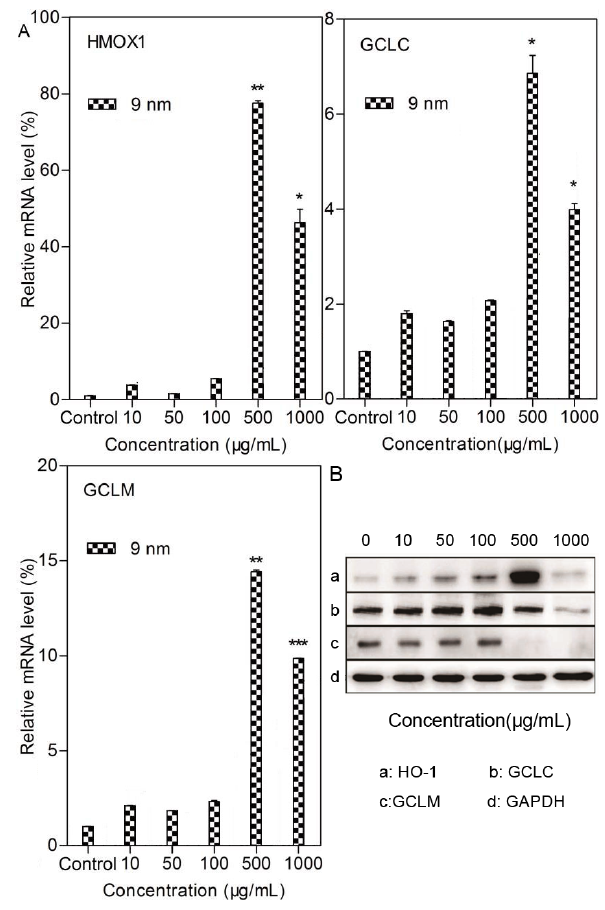
Figure 6: The expression of anti-oxidative genes and proteins in- duced by nanoparticles: (A) The expression levels of the HMOX- 1, GCLC, and GCLM mRNA in MCF-7 cells treated with 10 µ g/mL, 50 µ g/mL, 100 µ g/mL, 500 µ g/mL and 1000 µ g/mL Fe 3 O 4 NPs 9 nm particle size for 48 h. (B) The expression of anti-oxidative re- lated proteins in MCF-7 cells treated with 10 µ g/mL, 50 µ g/mL, 100 µ g/mL, 500 µ g/mL and 1000 µ g/mL Fe 3 O 4 NPs with 9 nm particle size for 48 h. Data were presented as mean ± S.D.